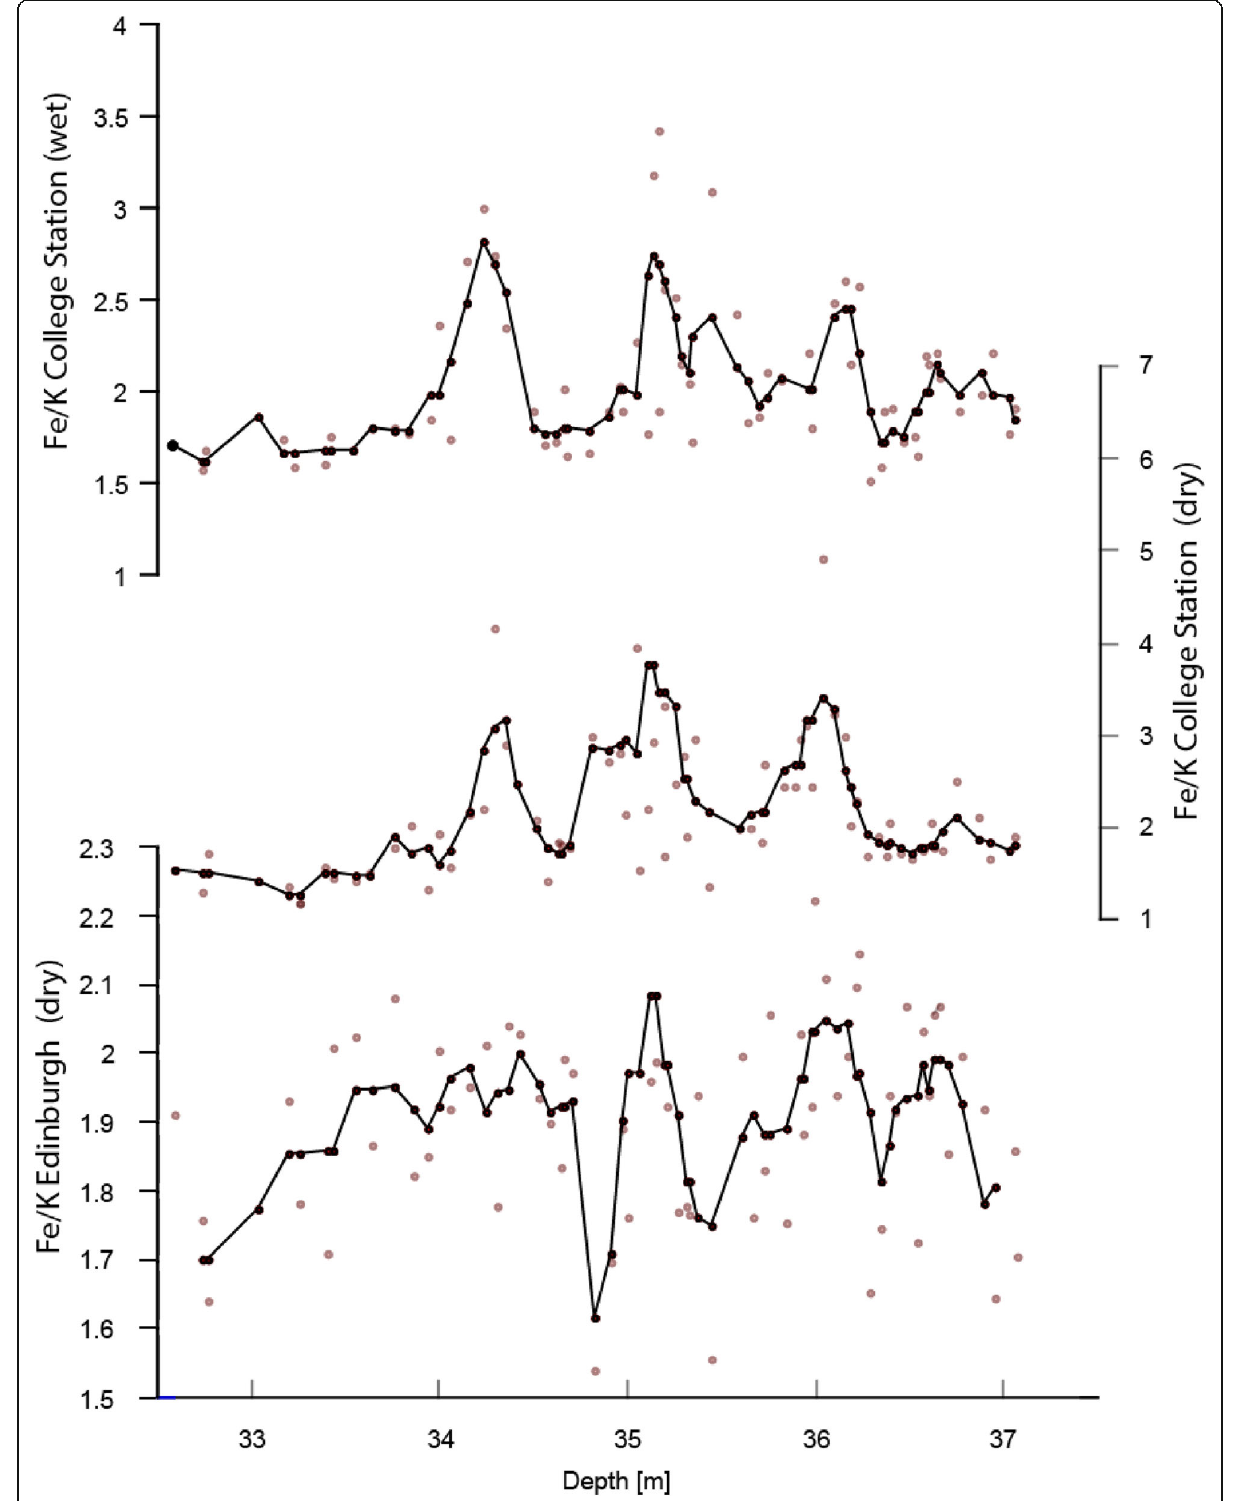
Fig. 7 Comparison of original ‘ wet ’ and ‘ dry ’ Fe/K data, measured directly on the core at College Station with ‘ dry ’ Fe/K data obtained from dried and ground core samples measured at the University of Edinburgh. Points indicate original data; black line represents a three-point moving